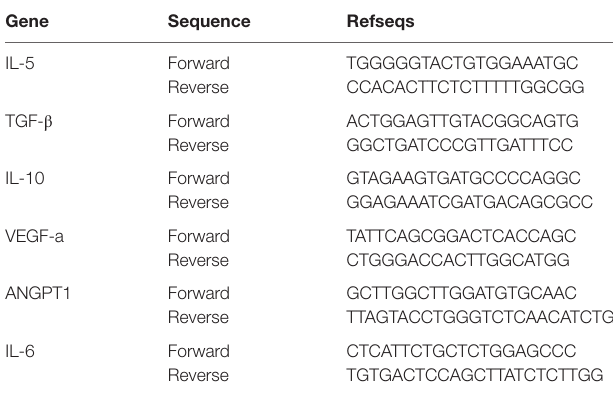
TaBle 2 | Sequence of primers for RT-PCR